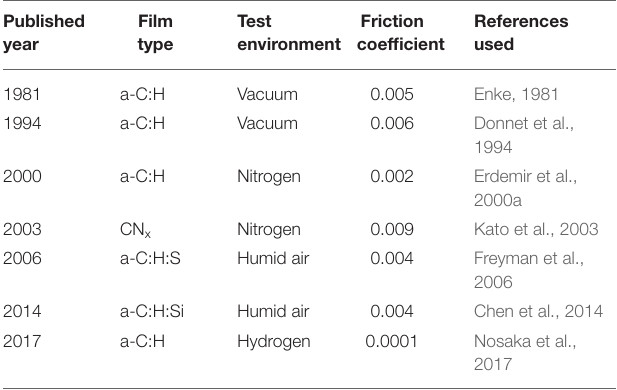
TABLE 1 | Research progress on the solid superlubricity achieved with different types of DLC films under various environments. Published year